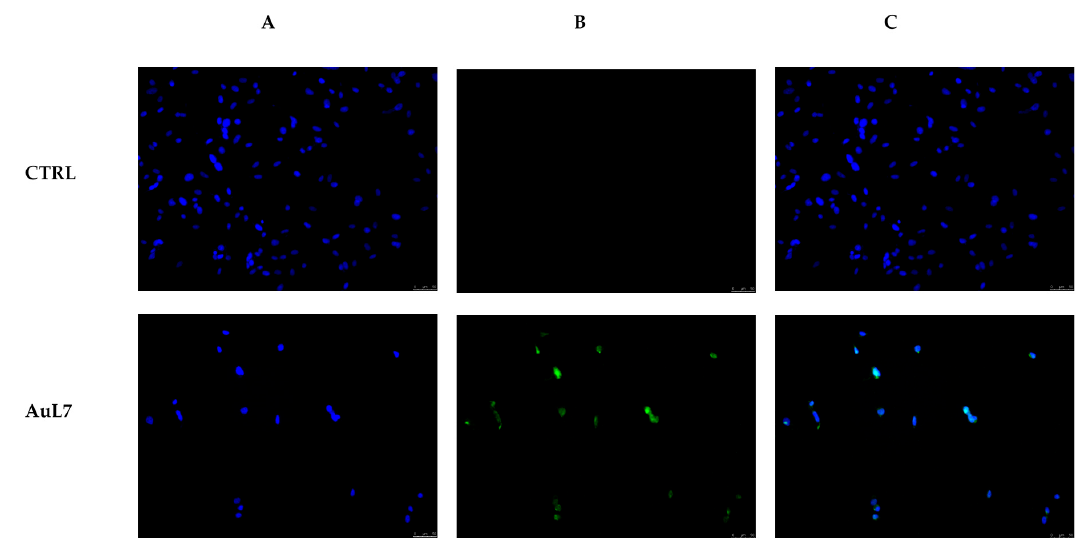
Figure 9. MDA-MB-231 cells were treated with AuL7 at a concentration corresponding to its IC 50 value or with the vehicle (CTRL) for 24 h. Processed cells were observed under an inverted fluorescence microscope at 20× magnification. The green nuclear fluorescence, in AuL7 -treated cells, indicates apoptotic death. Panels A : DAPI (CTRL and AuL7 ) excitation/emission wavelength 350 nm/460 nm. Panels B : CF™488A (CTRL and AuL7 ) excitation/emission wavelength 490 nm/515 nm. Panels C : a merge of panels A and B. Fields are representative of three separate experiments.